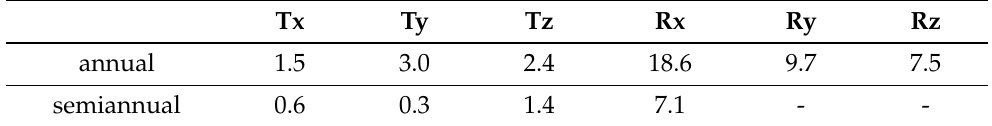
Table 4. The annual and semiannual amplitudes of the translation and rotation parameter time series estimated between JTRF2014 and IGS. Notes: The units for the annual and semiannual amplitudes of the translation and rotation parameters are mm and µ as,